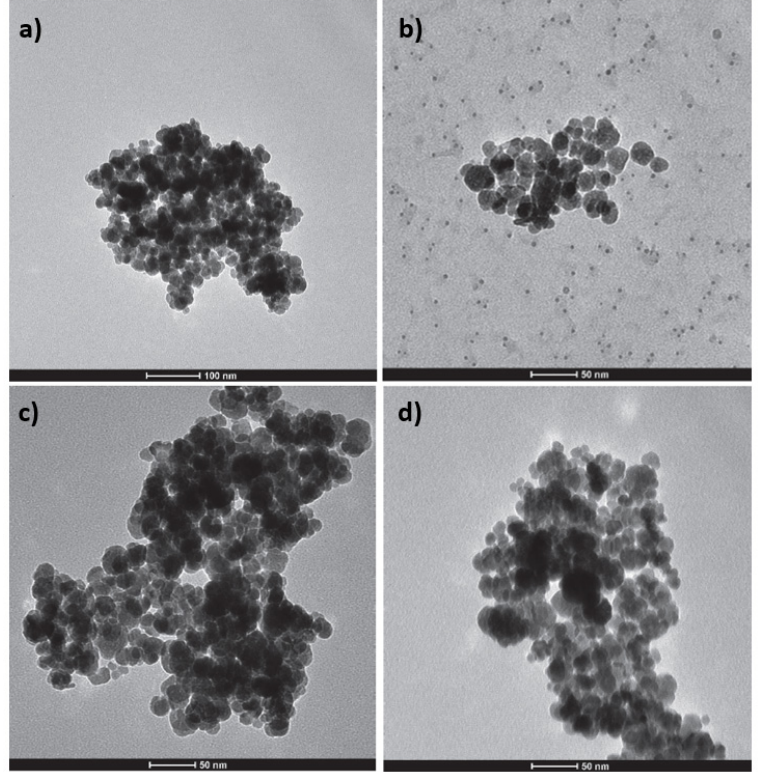
Figure 3. TEM images of the magnetite nanoparticles ( a ) and magnetite modified sorbent: canelo ( b ), eucalyptus ( c ) and laurel ( d